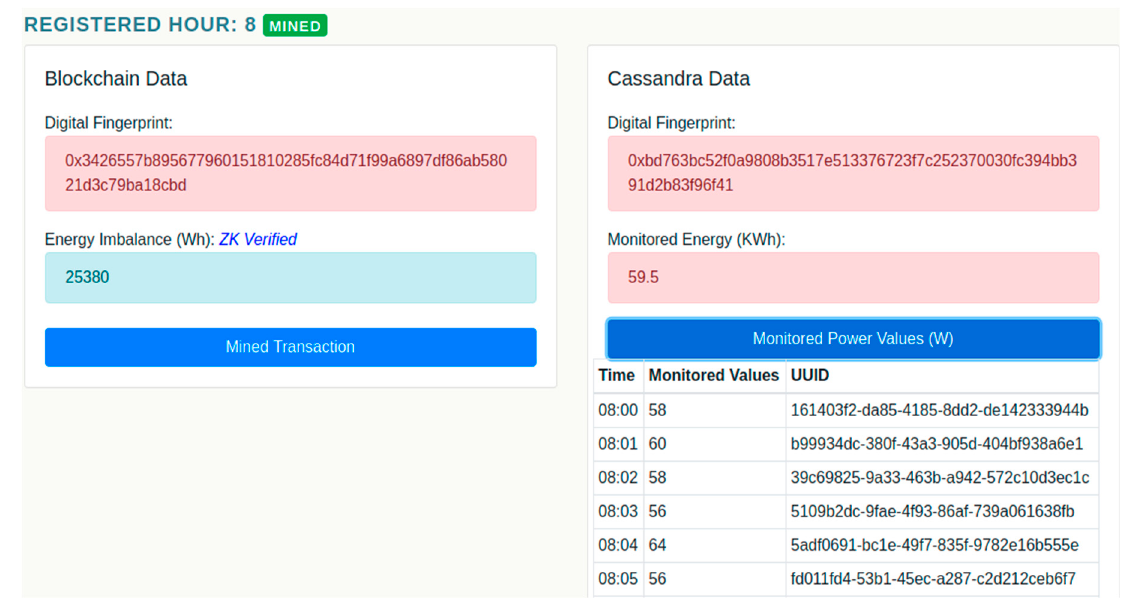
Figure 12. Validation of energy monitored values privately stored.